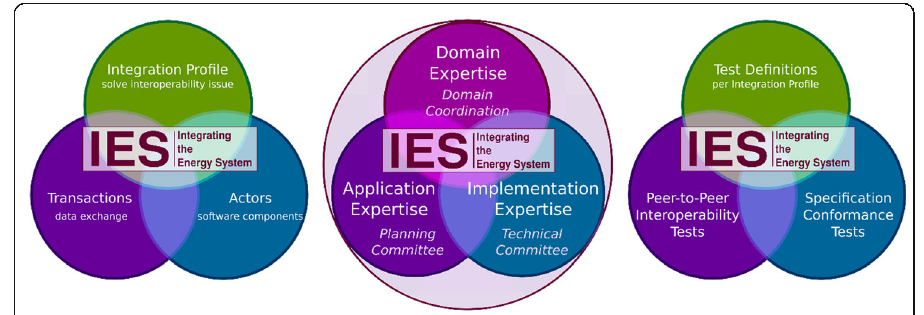
Fig. 2 Functional composition of Integration Profiles, Managing Committees, and Integration